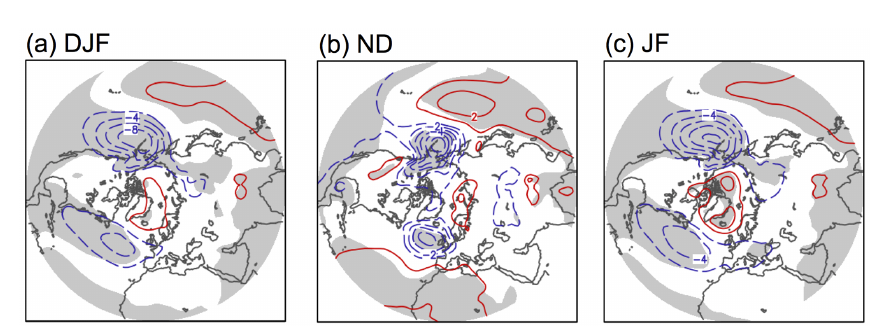
Figure 1. Sea level pressure (SLP) composites for El Niño minus La Niña events during 1920–2014 for the months shown on the panels. The ENSO events are defined by Nino3.4 amplitudes greater than 1 standard deviation. The contour interval is 2hPa in panels (a) and (c) and 1hPa in panel (b) , with red (blue) contours indicating positive (negative) anomalies. Gray shading indicates the 5% significance level for a two-tailed t test. All analyses in this paper use data from HadSST and NOAA-CIRES 20CR